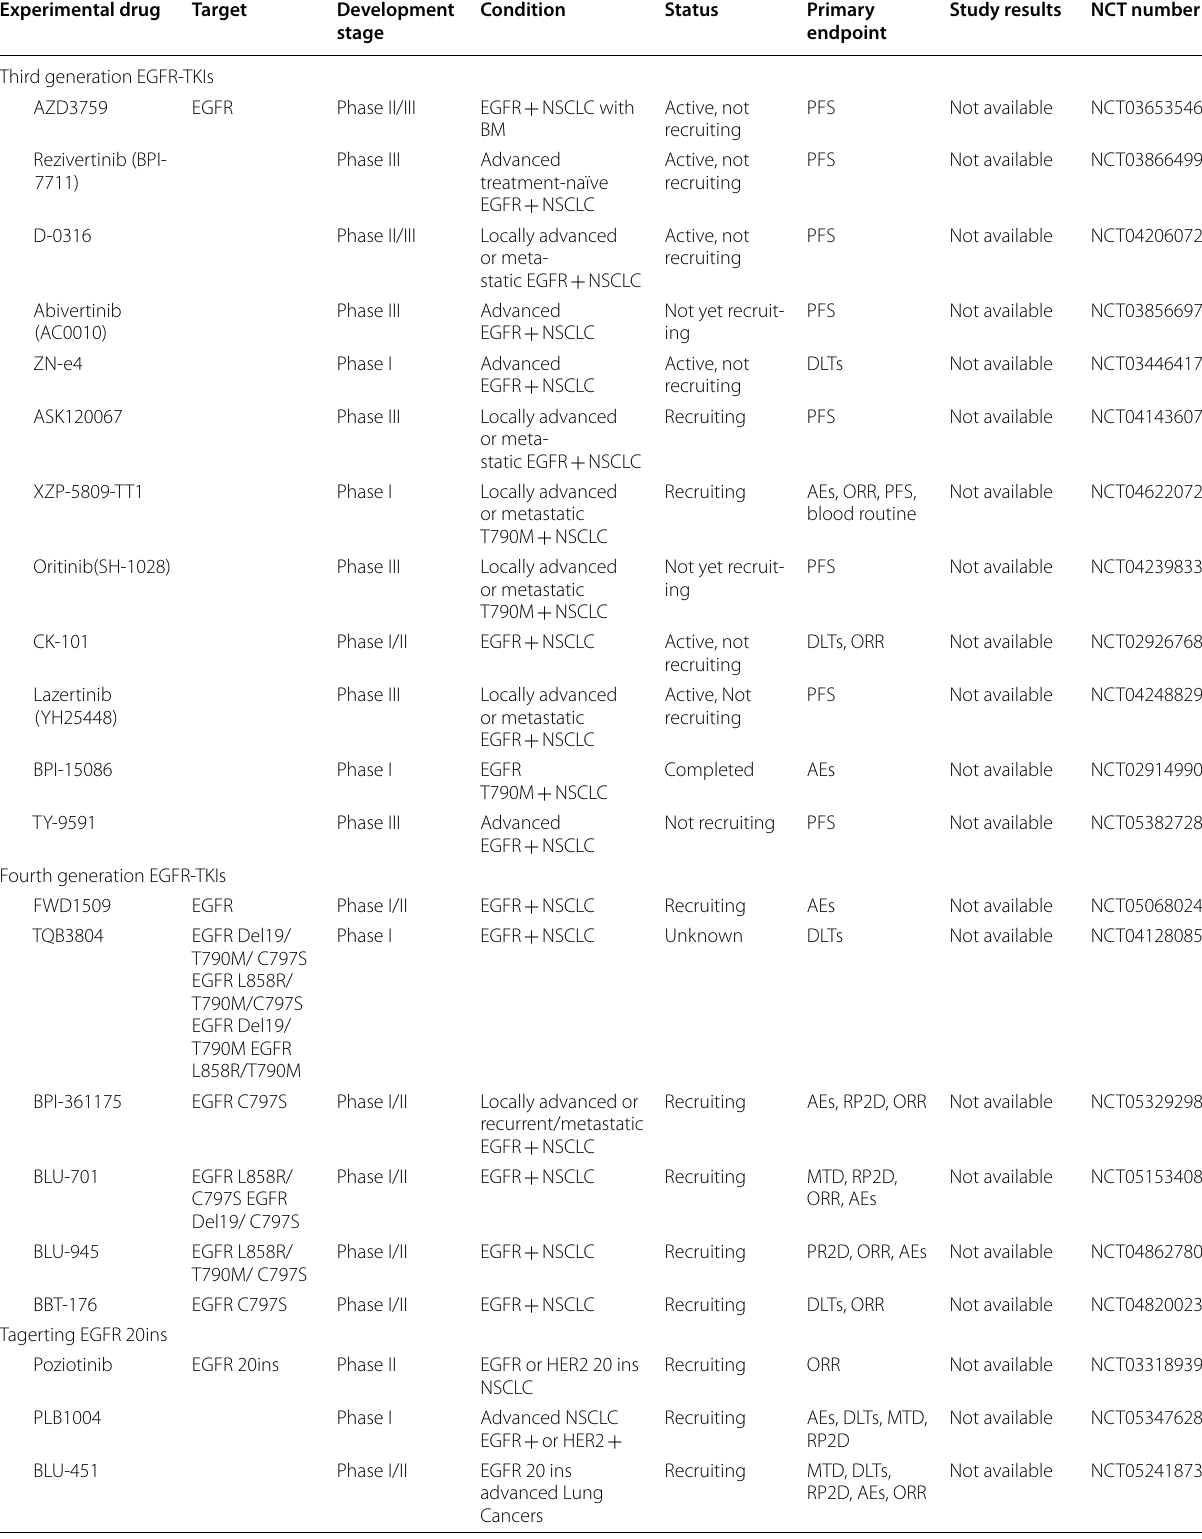
Table 1 Clinical trials of EGFR